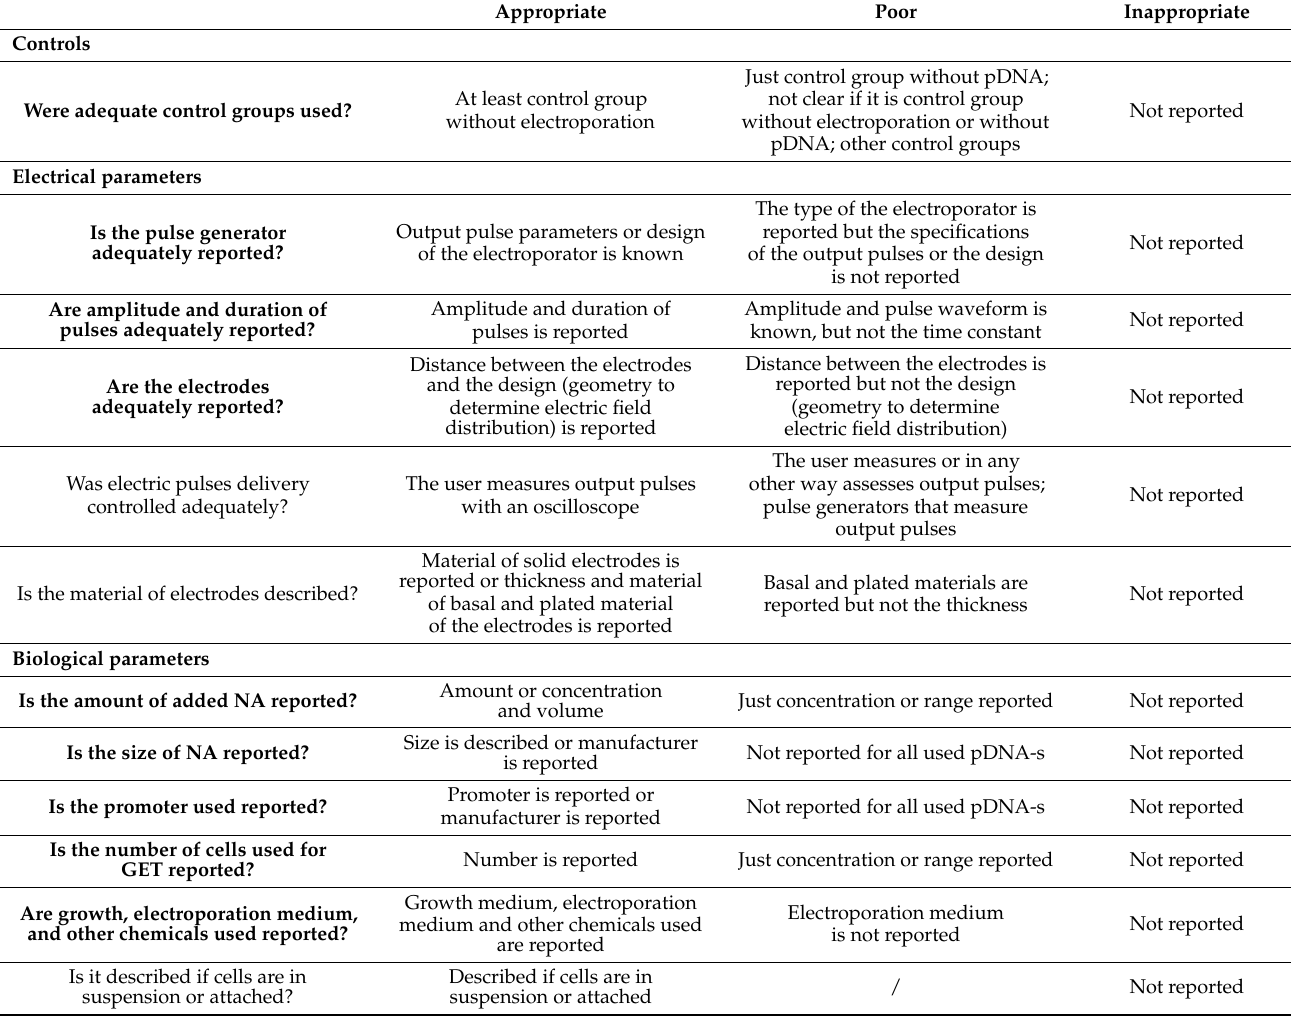
Table 2. Criteria for assessment of risk of